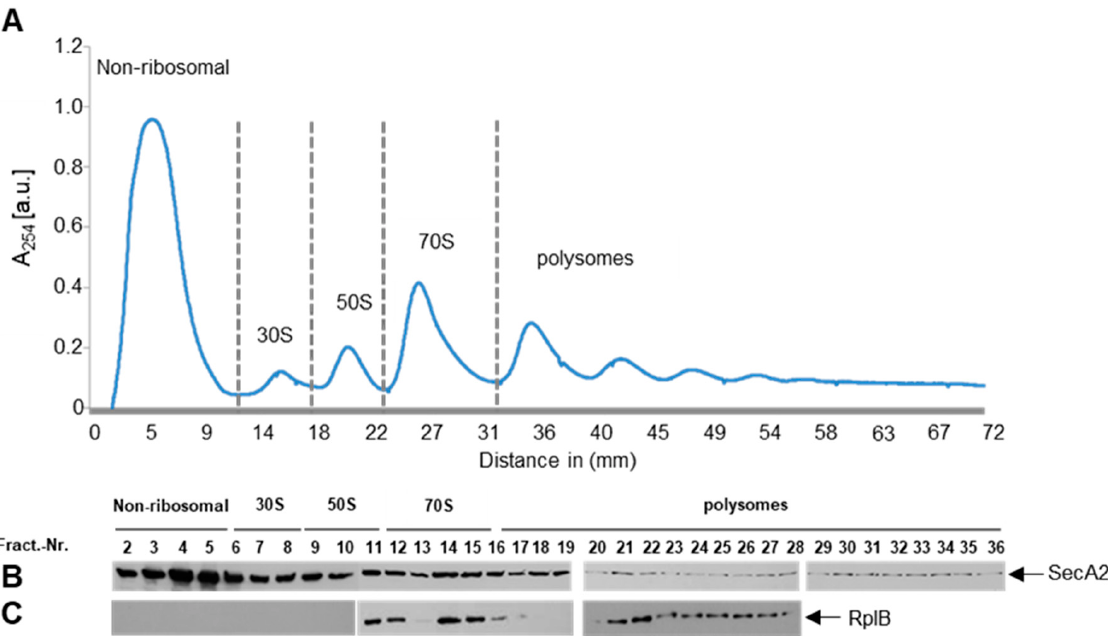
Figure 4. Detection of SecA2 on polysomes. ( A ) the ribosome profile of Lm- ∆ secA 2::SecA2 strep is depicted. The first gradient fractions show free ribosome-unbound low molecular weight proteins. The ribosomal components 30S, 50S, 70S and polysomes were detected at higher sucrose concentra- tion; and ( B , C ) Detection of SecA2 and the ribosomal protein RplB in different gradient fractions. Ribosomal peaks were normalized to the same gradient baseline by subtracting the area under (a.u.) the polysome profile for quantitative comparison.